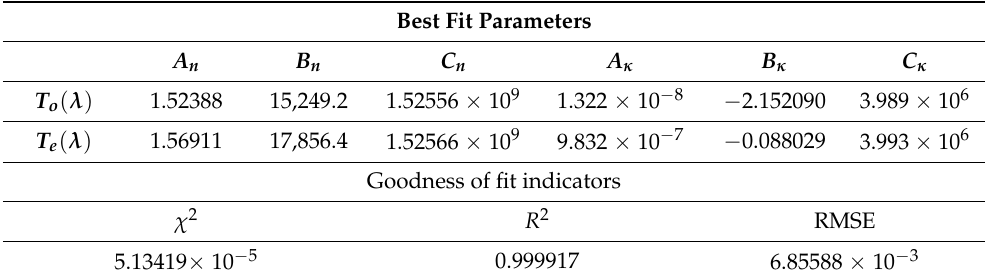
Table 1. Fitting parameters of Mylar sheet intensity transmittances T o ( λ ) and T e ( λ ) . Best Fit Parameters